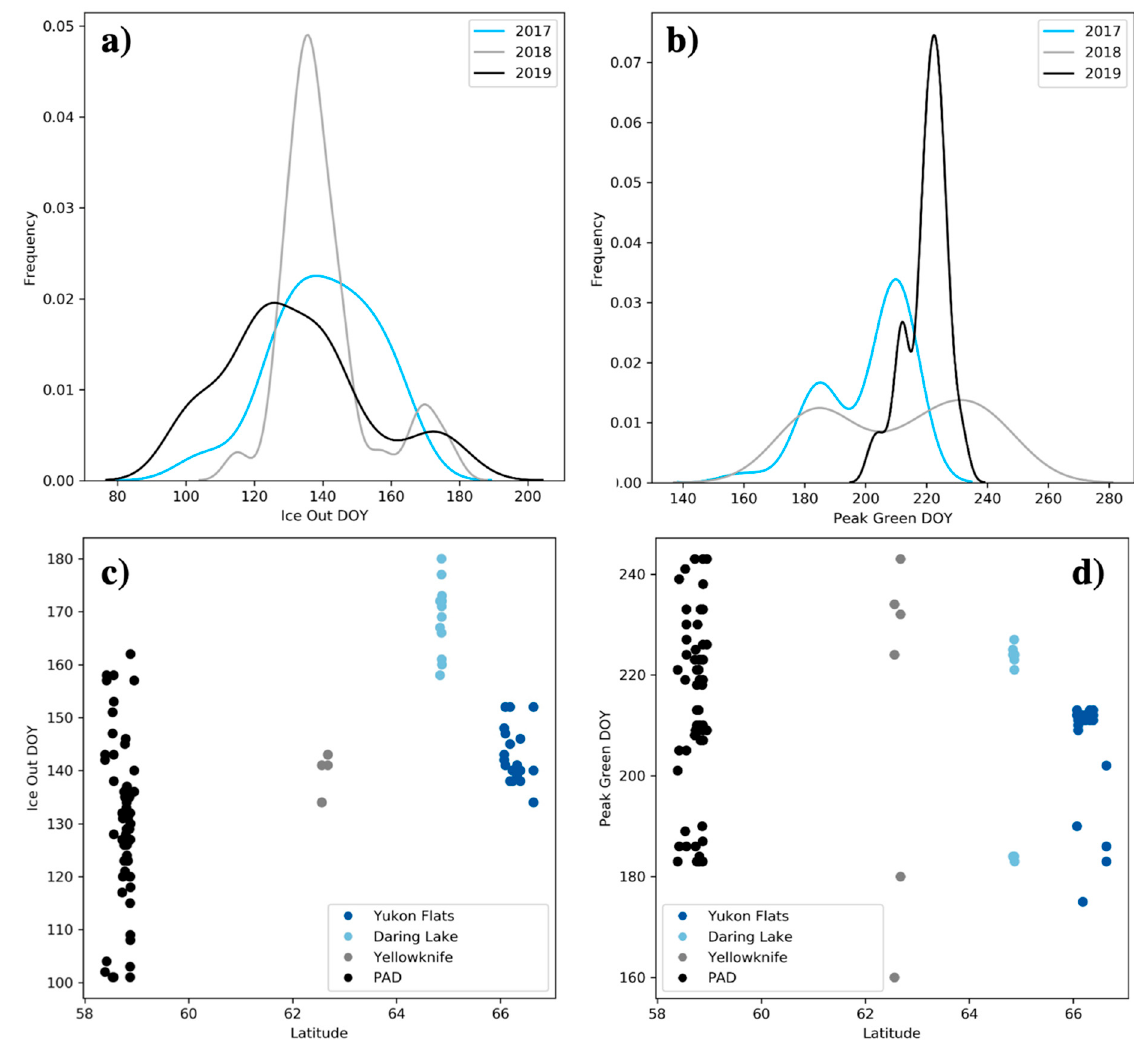
Figure 5. Kernel density estimate (KDE) showing distribution the day of year (DOY) of ( a ) ice-out and ( b ) green up where the density represents the spatial variability. Patterns by latitude are given for the ( c ) ice-out date (type II regression, y = 5.25x − 183.45, r 2 = 0.28, n = 35) and ( d ) peak green up (type II regression, y = − 5.61x + 553.47, r 2 = 0.01, n = 35) relative to latitude. We note that in number of points in ( c , d ) are the same ( n = 35 lakes for three years), except that in ( c ) Yellowknife sites had synchronous ice-out and thus plot on top of each other. Green-up was more variable, with the average peak green-up occurring on July 29th (Figure 5b). Peak green-up between years varied by 22 days (Figure 5b). The earliest